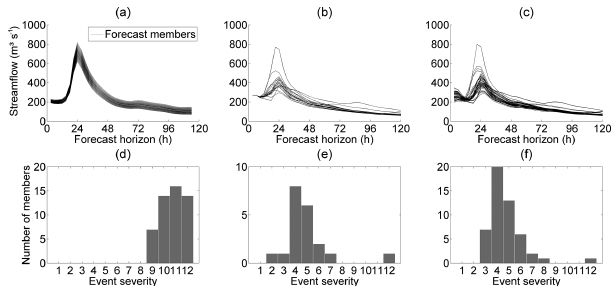
Figure 7. Separation of forecast members into 12 categories accord- ing to the magnitude of streamflow. The example is for forecasts emitted on 17 May 2014. (a) and (d) : dressed deterministic fore- casts; (b) and (e) meteorological ensemble-based forecasts; (c) and (f) meteorological ensemble+EnKF forecasts.